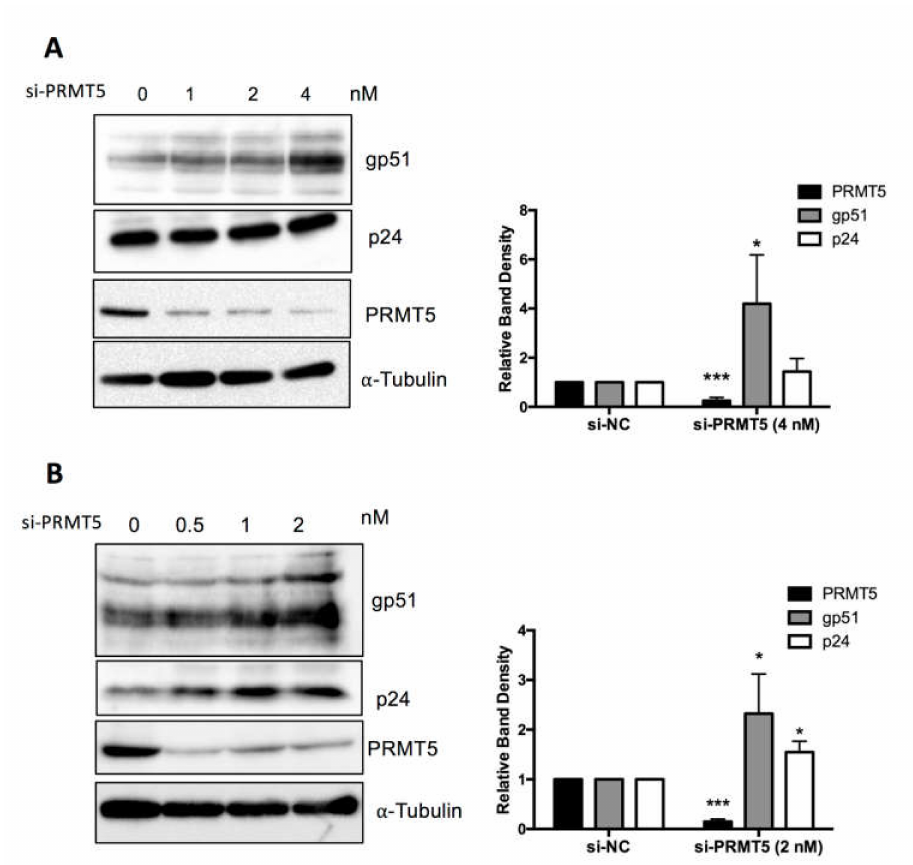
Figure 5. E ff ect of PRMT5 knockdown on BLV protein expression. FLK-BLV ( A ) or PK15-BLV ( B ) cells were transfected with scramble siRNA (si-NC) or siRNA targeting PRMT5 (si-PRMT5) at the indicated concentrations for 48 h for FLK-BLV or 72 h for PK15-BLV. Cell lysates were prepared and the expression of two viral proteins (Env gp51 and Gag p24) were assessed by Western blotting. Knockdown e ffi ciency was evaluated by evaluating PRMT5 protein expression by Western blotting. The relative band density of each protein normalized to α -tubulin expression is shown for each cell line. Error bars represent the standard deviation of three experiments. The p value was calculated by Student’s t -test. The asterisk indicates a significant di ff erence (* p ≤ 0.05, and *** p ≤ 0.001). Positions of BLV gp51 and p24, PRMT5, and α -tubulin proteins are